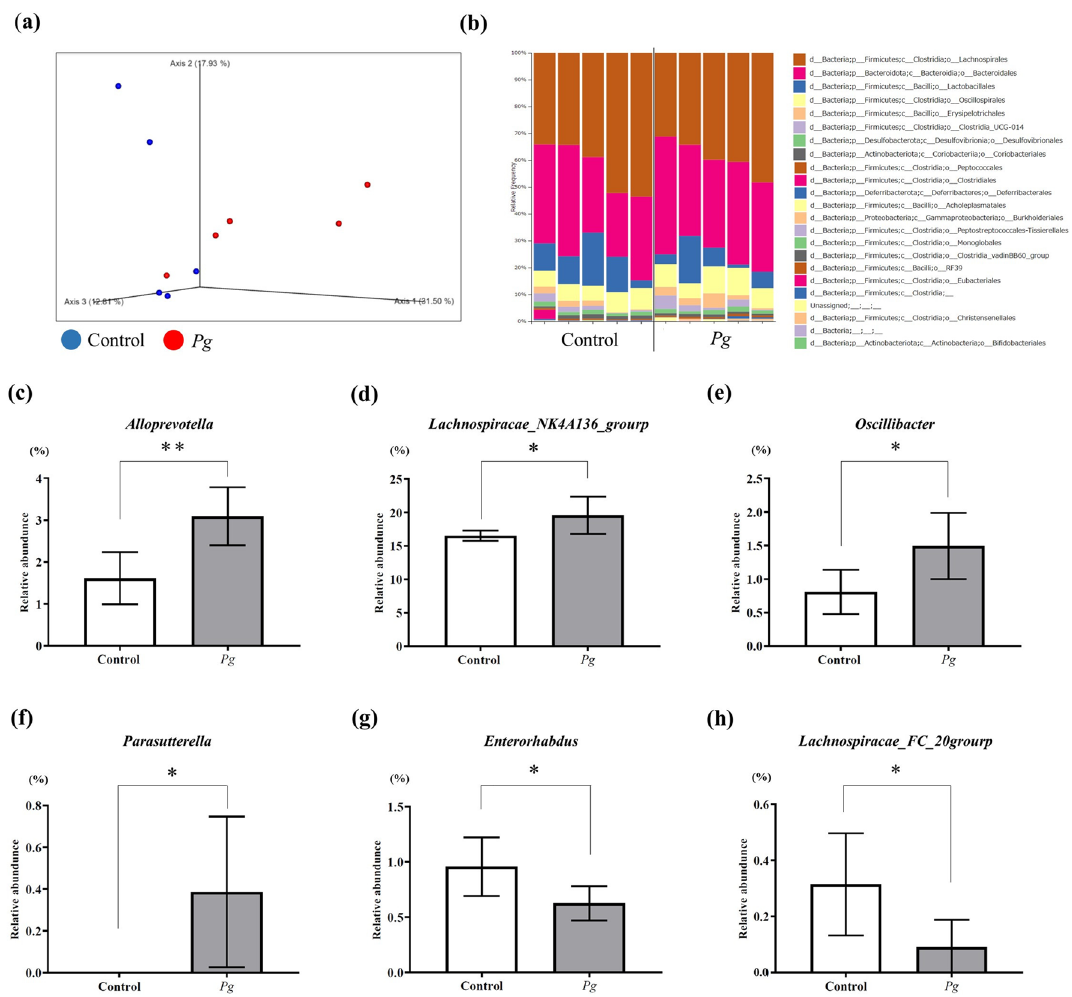
Figure 2. Analysis of the microbiota in both groups. ( a ) Unweighted UniFrac distances between the groups (red: Pg ; green: control). ( b ) Taxonomic bar plots at the order level for both groups. ( c – h ) There was a significant change in the relative abundance of six genera between groups (four genera increased, and two genera decreased). ( c ) Alloprevotella , ( d ) Lachnospiracae_NK4A136_group , ( e ) Oscillibacter, ( f ) Parasutterella , ( g ) Enterorhabdus, ( h ) Lachnospiracae_FCS020_group. Each group: n = 5. * p < 0.05, ** p <